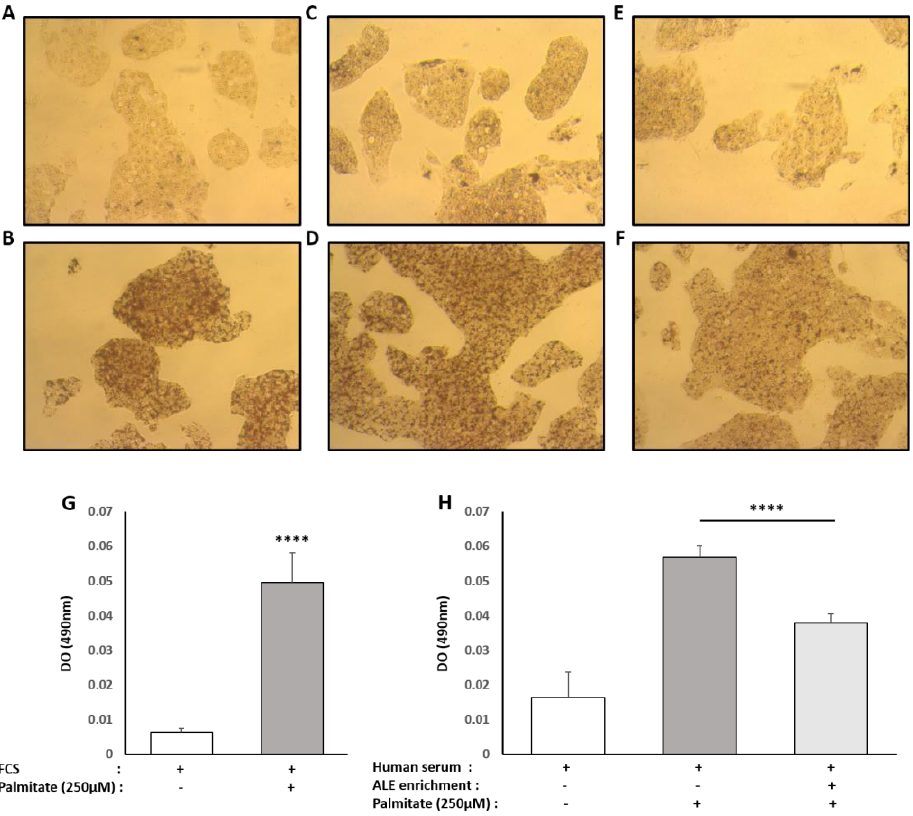
Figure 5. Effect of human serum enriched with ALE metabolites on total intracellular lipid content in HepG2 cells. HepG2 cells were preincubated with fetal calf serum ( A , B ), human naive serum ( C , D ) or ALE enriched human serum ( E , F ) for 24 h and stimulated with 250µM palmitate ( B , D , F ) or vehicle ( A , C , E ) for an additional 48 h. Intracellular lipid content was analyzed using an oil red coloration. After microscopical observation, the fixed dye was redissolved in 100% isopropanol, and the optical density was measured at 490 nm in order to quantify lipidic content ( G , H ). Palmitate increases intracellular lipid content independently of the origin of the serum (calf or human). The human serum enriched with ALE metabolites significantly limited the palmitate-induced steatosis. **** ( p < 0.0001).